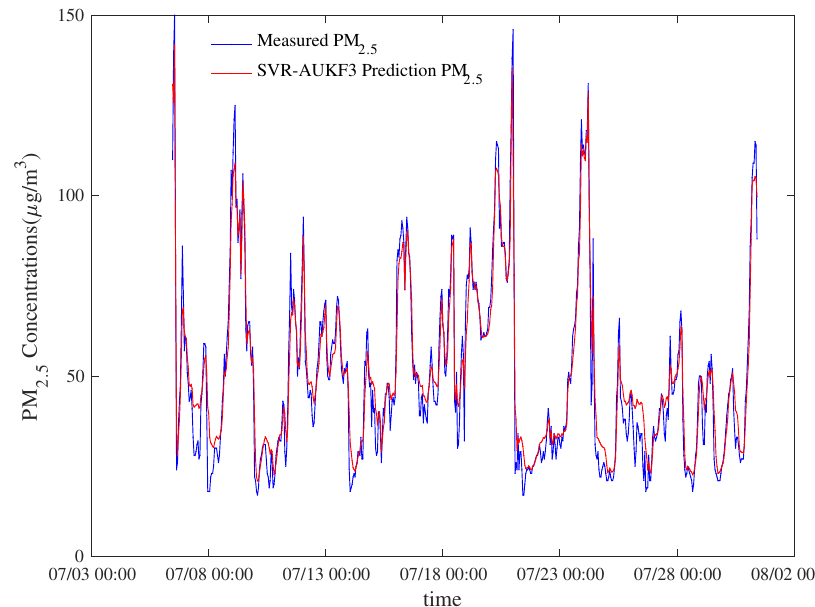
Figure 11. The PM 2.5 concentration prediction of SVR-AUKF3. The prediction residuals of SVR-AUKF3 are shown in Figure 12.